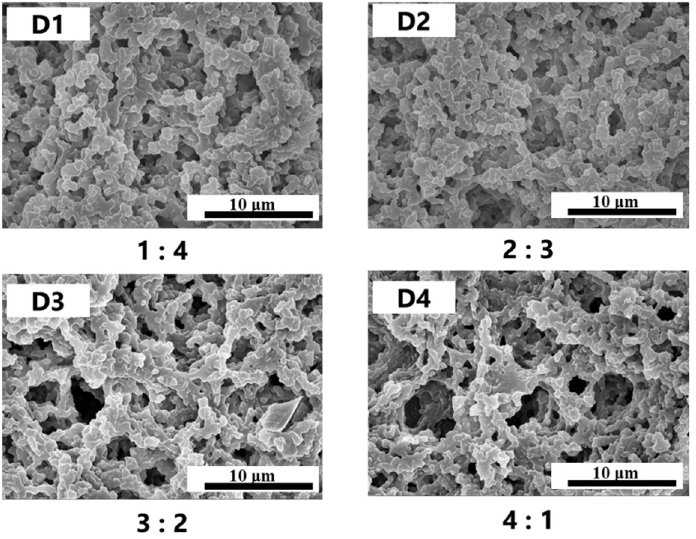
Figure 8. SEM photos of PDLC films with different monomer (Bis-EMA15/PEGDA700) content ratios: D1 (1:4), D2 (2:3), D3 (3:2), and D4 (4:1).